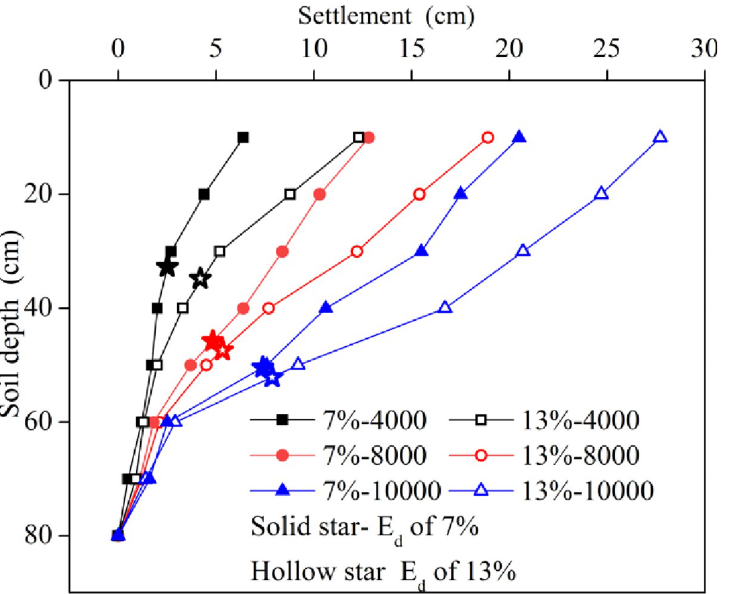
Fig 6. Curves of settlement verses the soil depth.